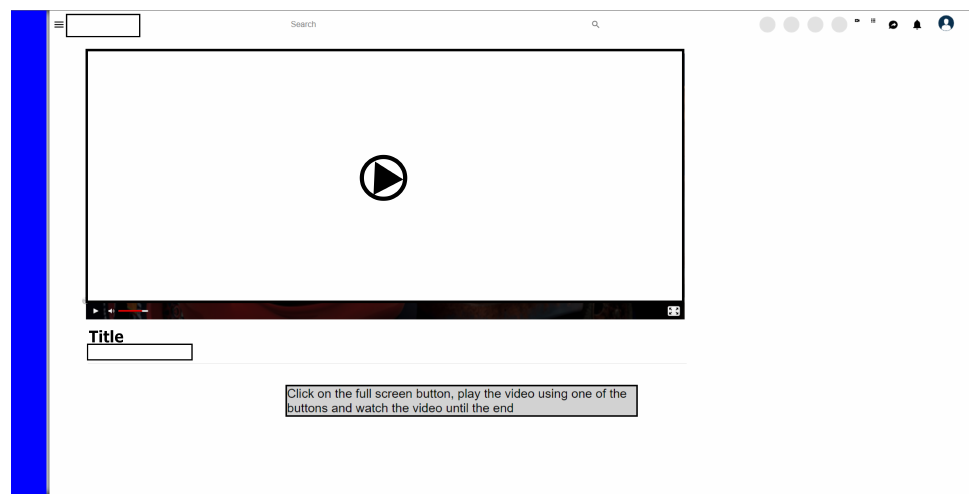
Figure 9. Simulated scenario 2 based on a generic video platform in a web service with PB.